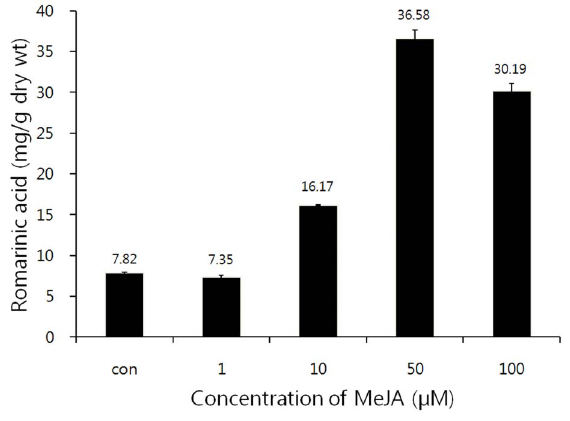
Figure 3. Time courses of rosmarinic acid production induced by application of MeJA with different concentrations in the suspension cell culture of A.rugosa . Each value is the mean of three replicates, and error bars indicate SDs.